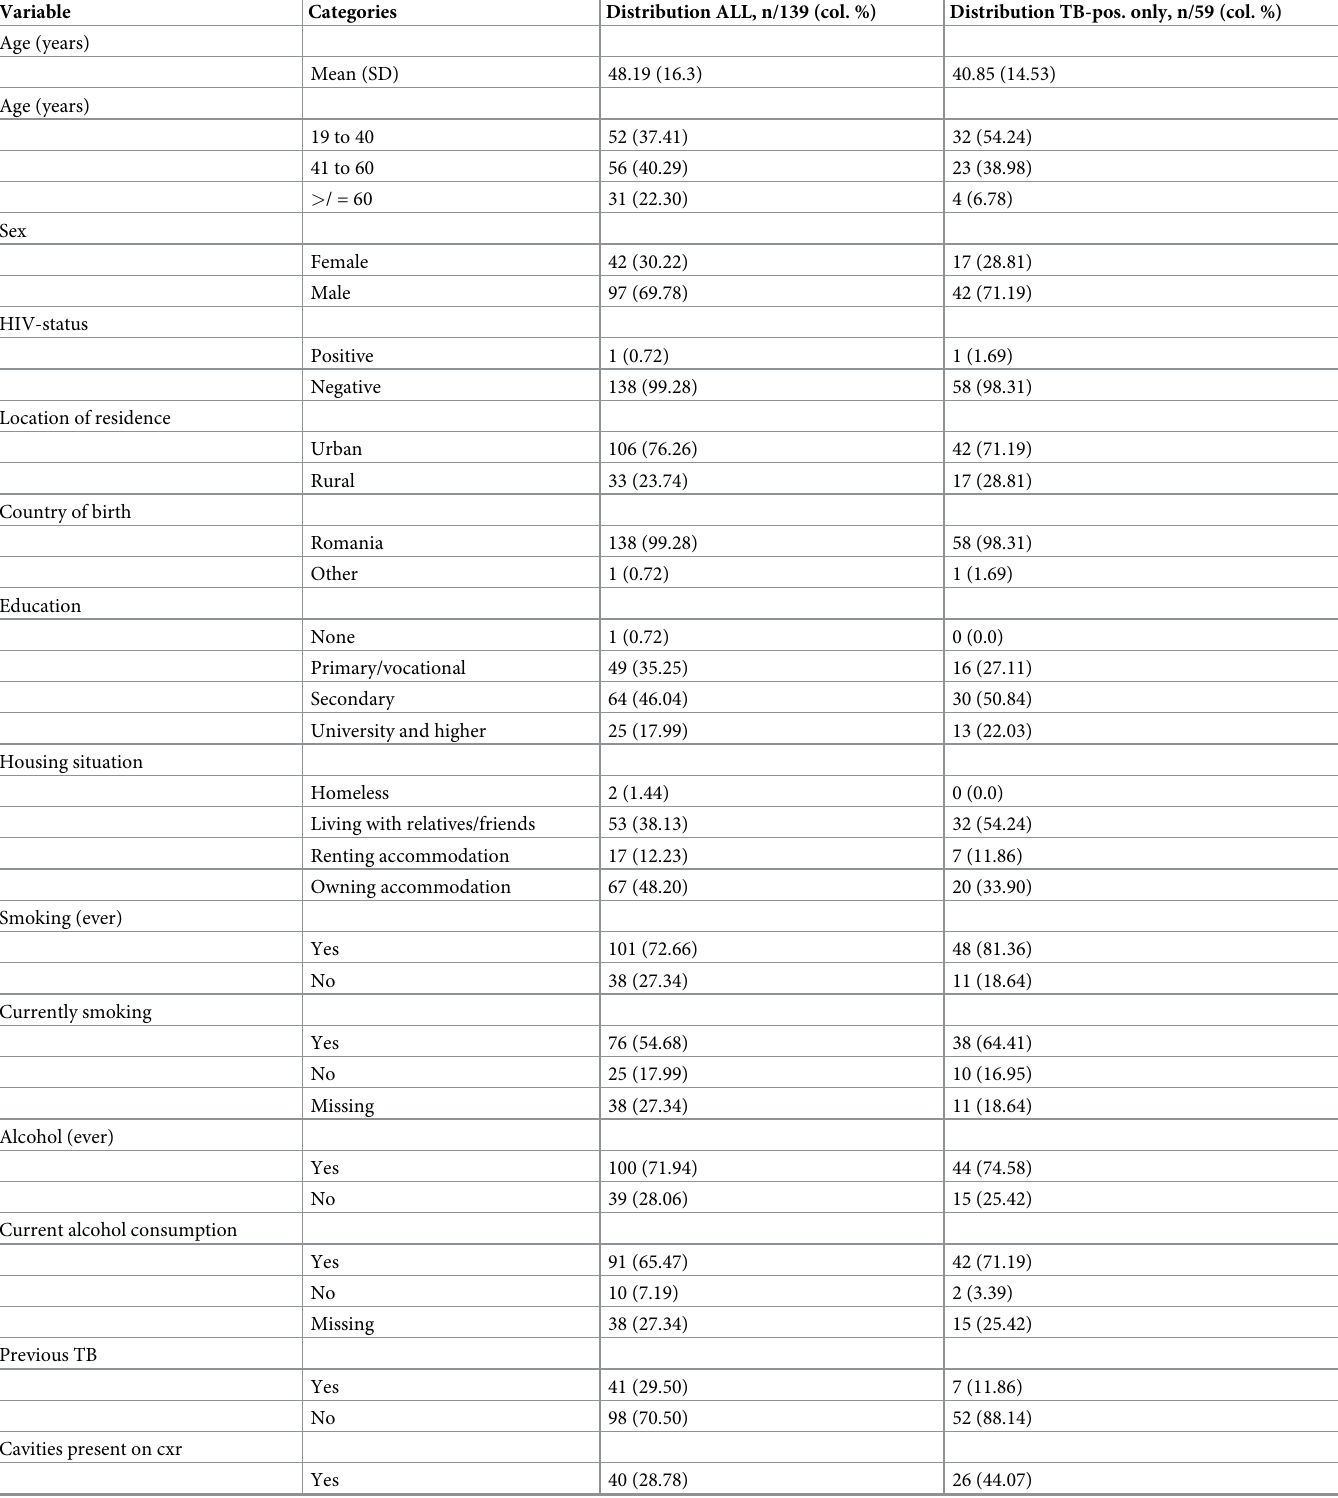
Table 1. Characteristics of study